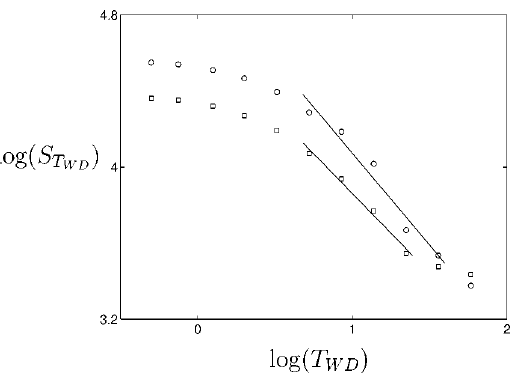
Fig. 4. Log–log plots of the length S T of the approximating poly- WD gon versus the polygonization tolerance T WD for cell images chosen from the normal ( (cid:14) ) and tumour ( 2 ) classes. The linear regression over the automatically selected range of T WD for each log–log plot is also shown.